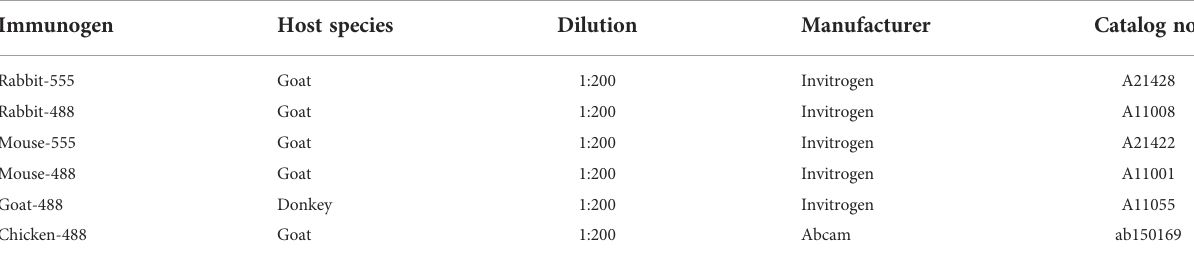
TABLE 2 List of secondary antibodies used for